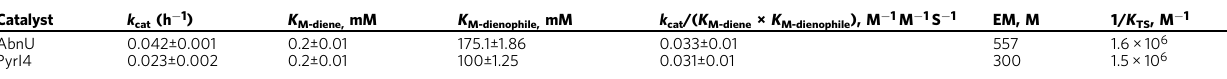
Fig. 2 Characterization of intermolecular Diels-Alderase reaction by AbnU and PyrI4. a HPLC analysis of reaction catalyzed by AbnU and PyrI4 and the background reaction. b Chiral-HPLC chromatograms of 3a and 3b after subtracting the background reaction. All chromatograms without subtraction are shown in the supplementary information (Supplementary Table 5 and Supplementary Fig. 6). Products produced in the non-enzymatic reaction are also shown for the respective reaction as background. Assignment of the stereoisomers is based on the previous literature 30 . On the top chemical diagrams show the relative stereochemistry of each of the stereoisomer. R1 is the diene region of the molecule while R2 is the dienophile part as depicted in Fig. 1. c Plot of effective molarity (EM = k cat / k uncat ) versus catalytic pro fi ciency (1/ K TS = [ k cat / K M-diene × K M-dienophile )]/ k uncat ) for all the reported DAses namely catalytic antibodies and ribozymes ( ♦ ), designed arti fi cial DAses ( (cid:129) ), AbnU ( ■ , blue) and PyrI4 ( ■ , purple). Table 1 Kinetic parameter for AbnU and PyrI4 measured at 37 °C in PBS buffer, pH 7.4. Catalyst